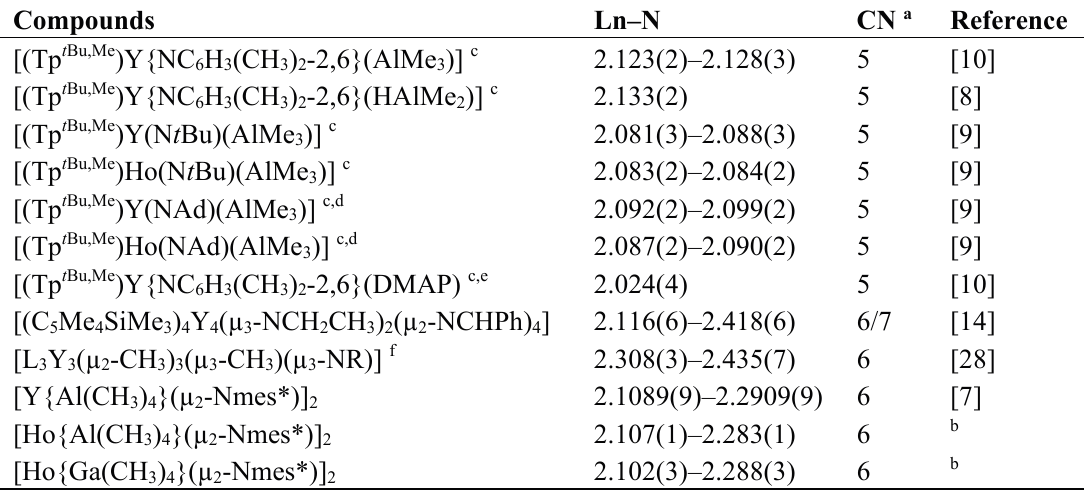
Table 2. Selected Y–N(imido) and Ho–N(imido) bond lengths